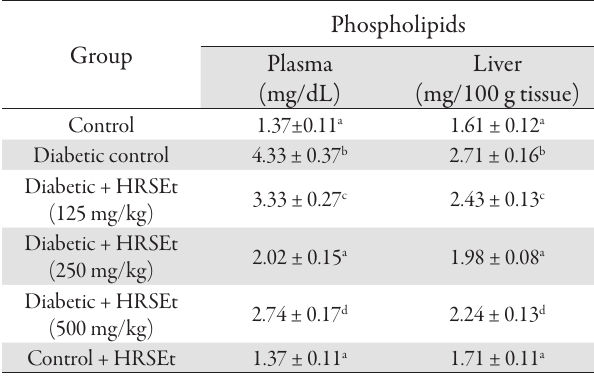
Tab. 10. Effect of HRSEt on the activities of phospholipids in